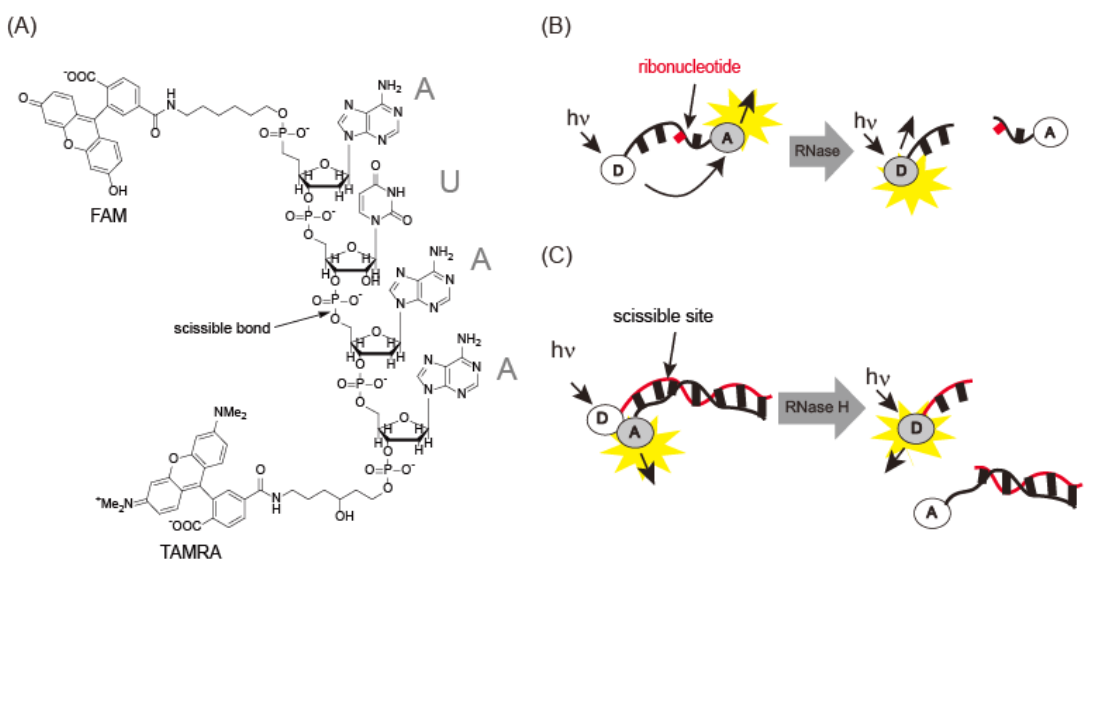
Figure 7. ( A ) Chemical structure of the FRET probe for RNase A detection; ( B ) RNase A and ( C ) RNase H detection with FRET